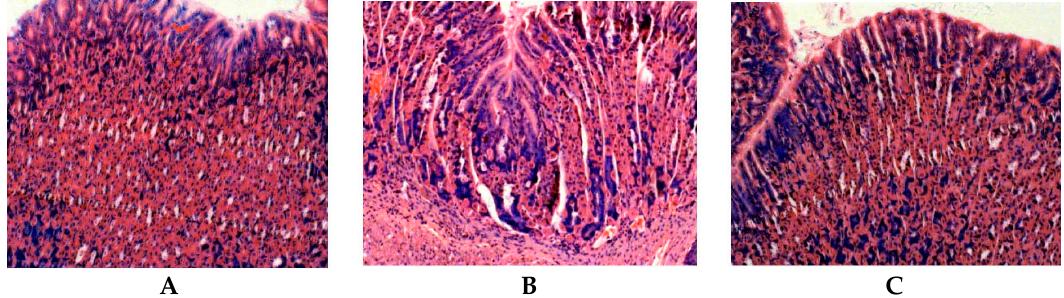
A B C A B C B C Figure 2. The observation of resveratrol on H. pylori -caused histological changes by histopathological Figure 2. The observation of resveratrol on H. pylori -caused histological changes by histopathological Figure 2. The observation of resveratrol on H. pylori -caused histological changes by histopathological Figure 2. The observation of resveratrol on H. pylori -caused histological changes by histopathological analysis of the mouse stomach (HE stain, 200×) ( A ) Normal control animals: Epithelial cells are analysis of the mouse stomach (HE stain, 200×) ( A ) Normal control animals: Epithelial cells are analysis of the mouse stomach (HE stain, 200×) ( A ) Normal control animals: Epithelial cells are analysis of the mouse stomach (HE stain, 200 ˆ ) ( A ) Normal control animals: Epithelial cells are arranged in neat rows and there are very few inflammatory cells scattered in epithelial tissues. arranged in neat rows and there are very few inflammatory cells scattered in epithelial tissues. arranged in neat rows and there are very few inflammatory cells scattered in epithelial tissues. arranged in neat rows and there are very few inflammatory cells scattered in epithelial tissues. Scored 0.25 ± 0.03; ( B ) H. pylori -infected model animals: Heavy infiltration of granulocytes, Scored 0.25 ± 0.03; ( B ) H. pylori -infected model animals: Heavy infiltration of granulocytes, Scored 0.25 ± 0.03; ( B ) H. pylori -infected model animals: Heavy infiltration of granulocytes, Scored 0.25 ˘ 0.03; ( B ) H. pylori -infected model animals: Heavy infiltration of granulocytes, lymphocytes and plasma cells in tissues. Scored 2.87 ± 0.46; ( C ) H. pylori -infected animals treated lymphocytes and plasma cells in tissues. Scored 2.87 ± 0.46; ( C ) H. pylori -infected animals treated lymphocytes and plasma cells in tissues. Scored 2.87 ˘ 0.46; ( C ) H. pylori -infected animals treated lymphocytes and plasma cells in tissues. Scored 2.87 ± 0.46; ( C ) H. pylori -infected animals treated with resveratrol: Infiltration of only a few lymphocytes and inflammation in epithelial tissues. Scored with resveratrol: Infiltration of only a few lymphocytes and inflammation in epithelial tissues. Scored with resveratrol: Infiltration of only a few lymphocytes and inflammation in epithelial tissues. with resveratrol: Infiltration of only a few lymphocytes and inflammation in epithelial tissues. Scored 1.3 ± 0.18. 1.3 ± 0.18. Scored 1.3 ˘ 0.18. 1.3 ± 0.18.